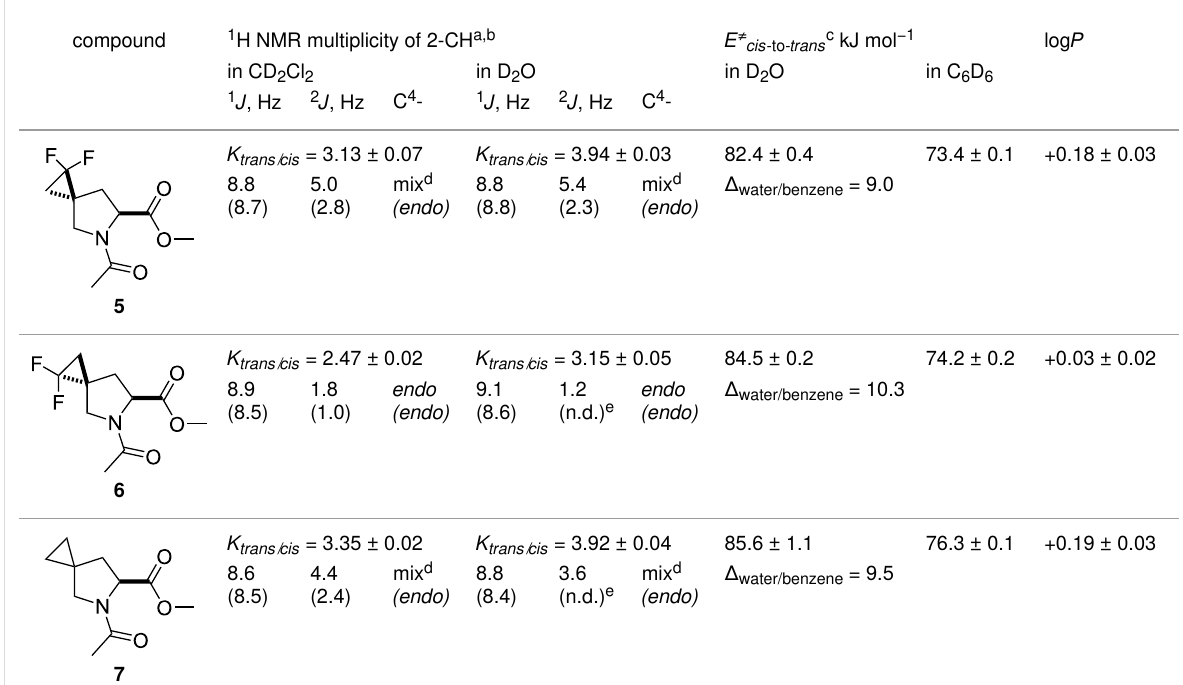
Table 4: Experimental data for compounds 5 – 7 .